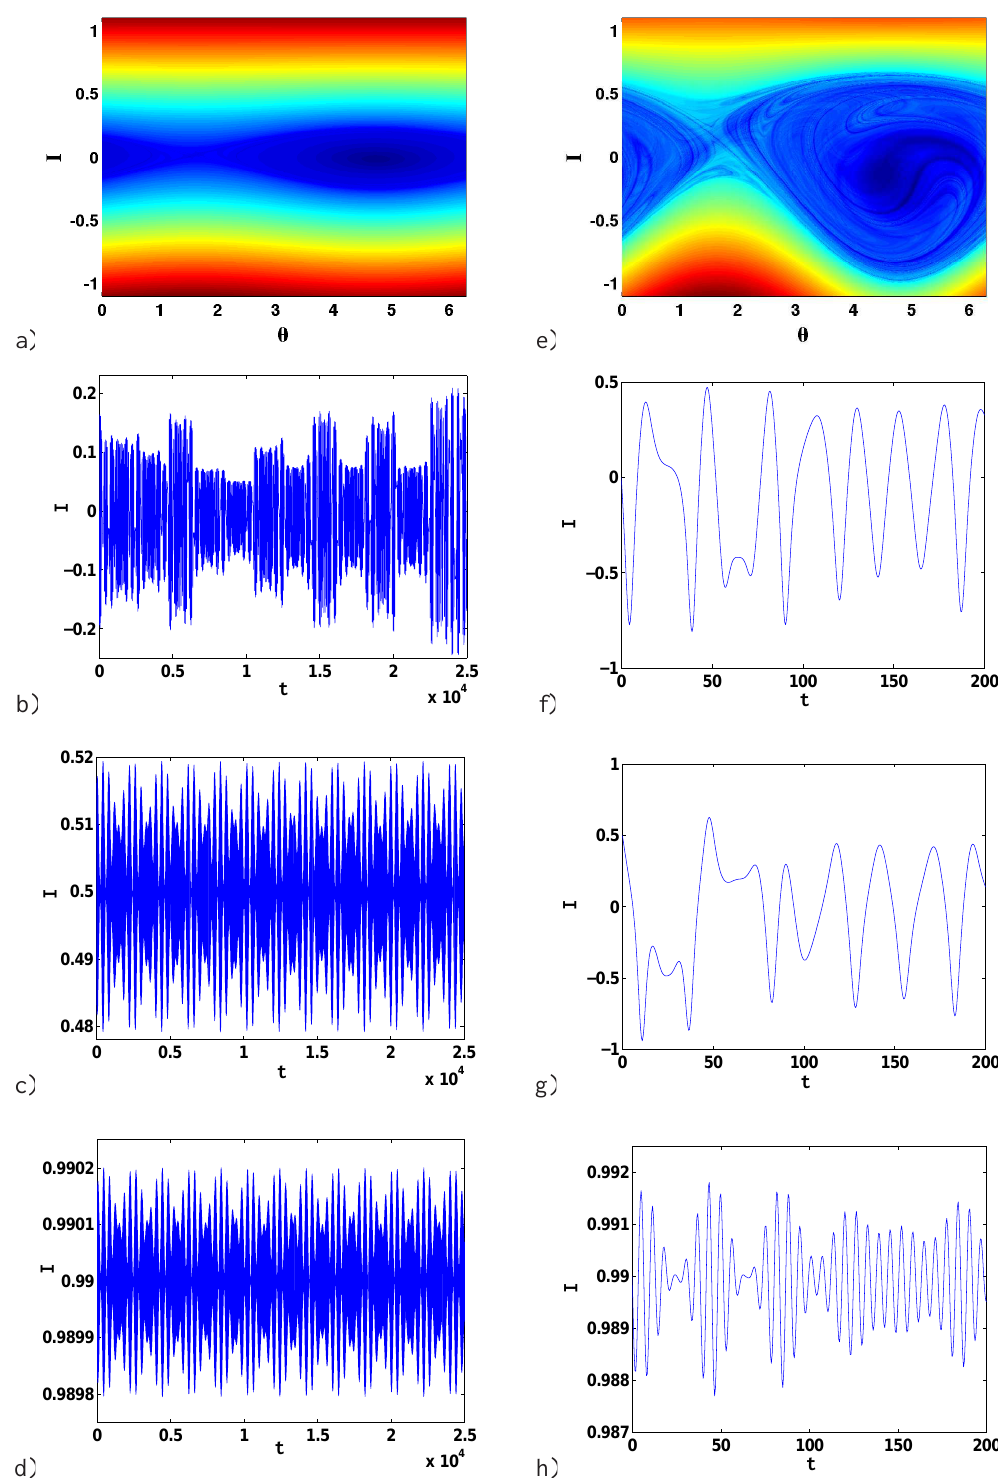
Fig. 5. Results obtained for the time dependence given by Eq. (37). The first column is for ε = 0 . 01, √ ǫ = 0 . 1 . a) Lagrangian descriptor evaluated in the domain [ 0 , 2 π ]×[− 1 . 1 , 1 . 1 ] at t = 0 for τ = 160; (b) , (c) , and (d) show the I component of the trajectory as a function of time for the following initial conditions: (b) θ = 0 ,I = 0; (c) θ = 0 ,I = 0 . 5; (d) θ = 0 ,I = 0 . 99. The second column is for ε = 0 . 1, √ ε = 0 . 31623. (e) Lagrangian descriptor evaluated in the domain [ 0 , 2 π ]×[− 1 . 1 , 1 . 1 ] at t = 0 for τ = 160; (f) , (g) , and (h) show the I component of the trajectory as a function of time for the following initial conditions: (f) θ = 0 ,I = 0; (g) θ = 0 ,I = 0 . 5; (h) θ = 0 ,I = 0 .